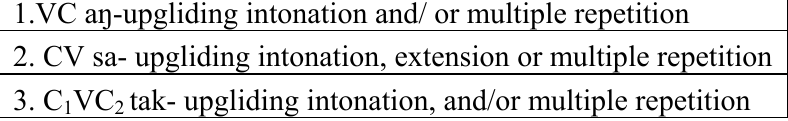
Table 4. Monosyllabic ideophone structures.